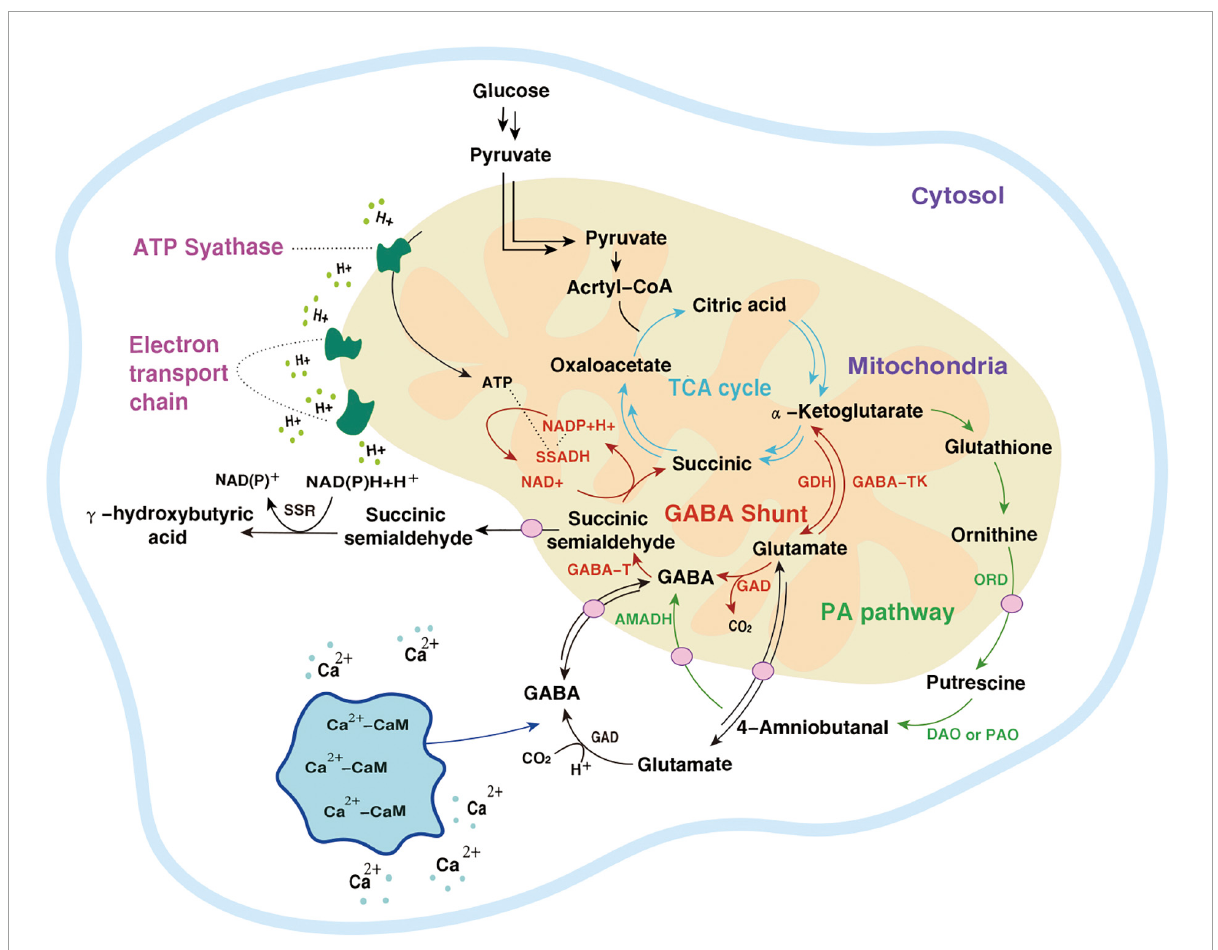
FIGURE3 Two metabolic pathways of GABA. , the TCA cycle; , the GABA shunt; , the PA pathway; , other pathways; , a transporter; , the electron transport